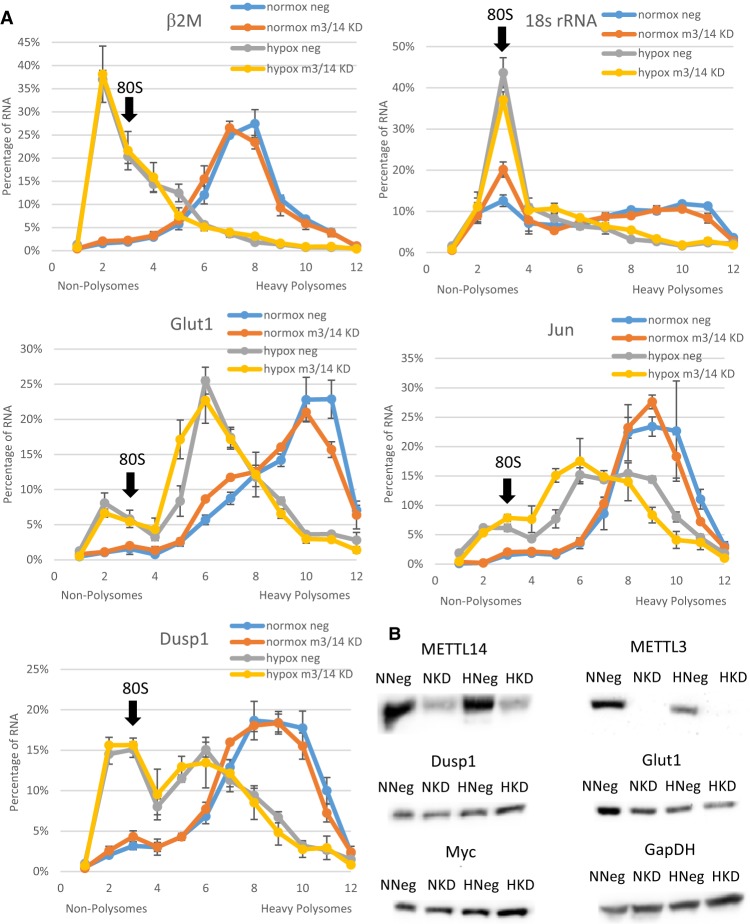
Translation rates and protein output are not affected by loss of m6A. HEK-293T cells harvested after 72 h transfection with METTL3/14 siRNA (M3/14 KD) or negative control siRNA (neg) and 24 h of normoxic (normox) or hypoxic (hypox) conditions. (A) Polysome profiling of extracts separated by differential centrifugation through sucrose gradients. qRT-PCR analysis of the fractions shows percentage of individual mRNA in each fraction. Error bars represent SEM of three experiments. Fraction containing 80S peak is marked. (B) Western blots of 50 µg of protein lysates of normoxic negative control siRNA (NNeg), normoxic METTL3/14 knockdown (NKD), hypoxic negative control (HNeg), hypoxic METTL3/14 knockdown (HKD) (representative of three experiments).